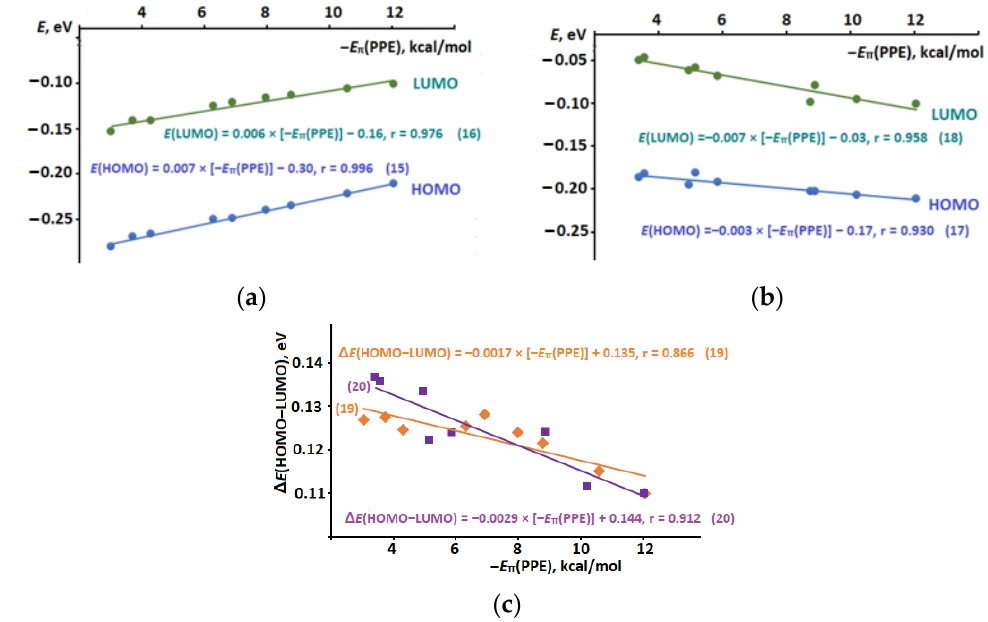
Figure 11. Dependencies of the E (HOMO) and E (LUMO) energies on − E π (PPE) for subseries Ia ( a ) and Ib ( b ); dependency of ∆ E (HOMO–LUMO) energy gap on − E π (PPE) for subseries Ia,b ( c ) of studies